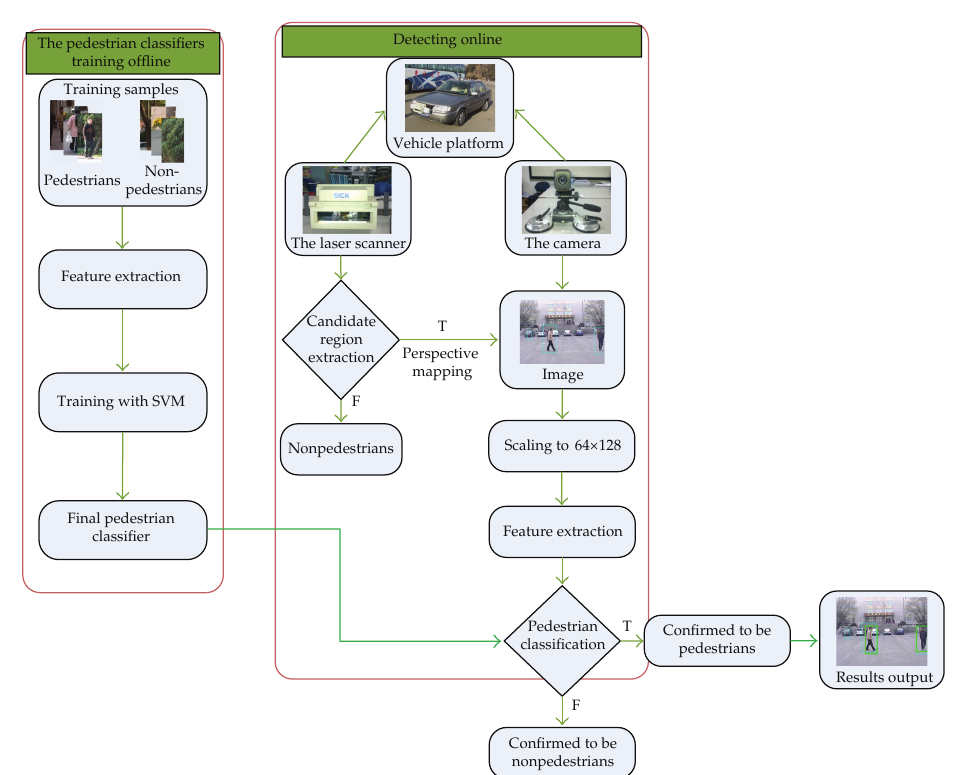
Figure 2: Architecture of the proposed multisensor pedestrian recognition